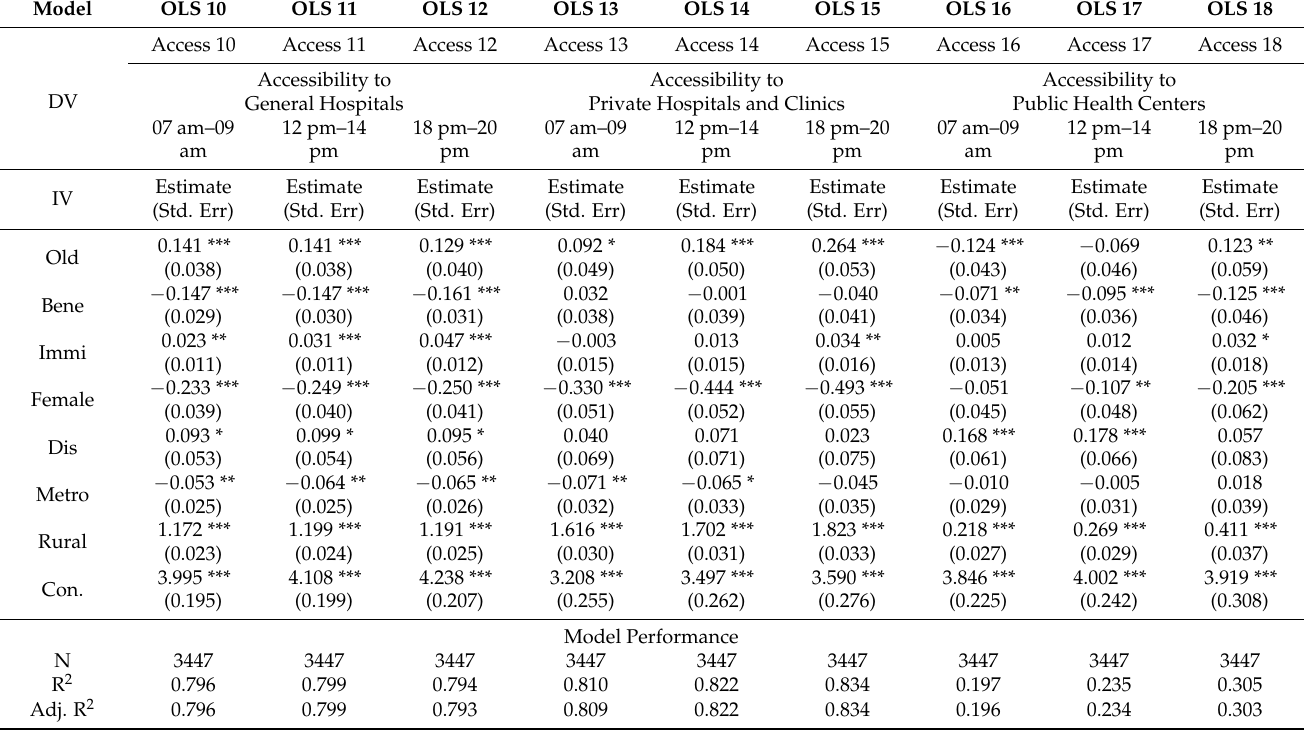
Table 7. Socioeconomic Inequality in Accessibility to Healthcare Services by Public